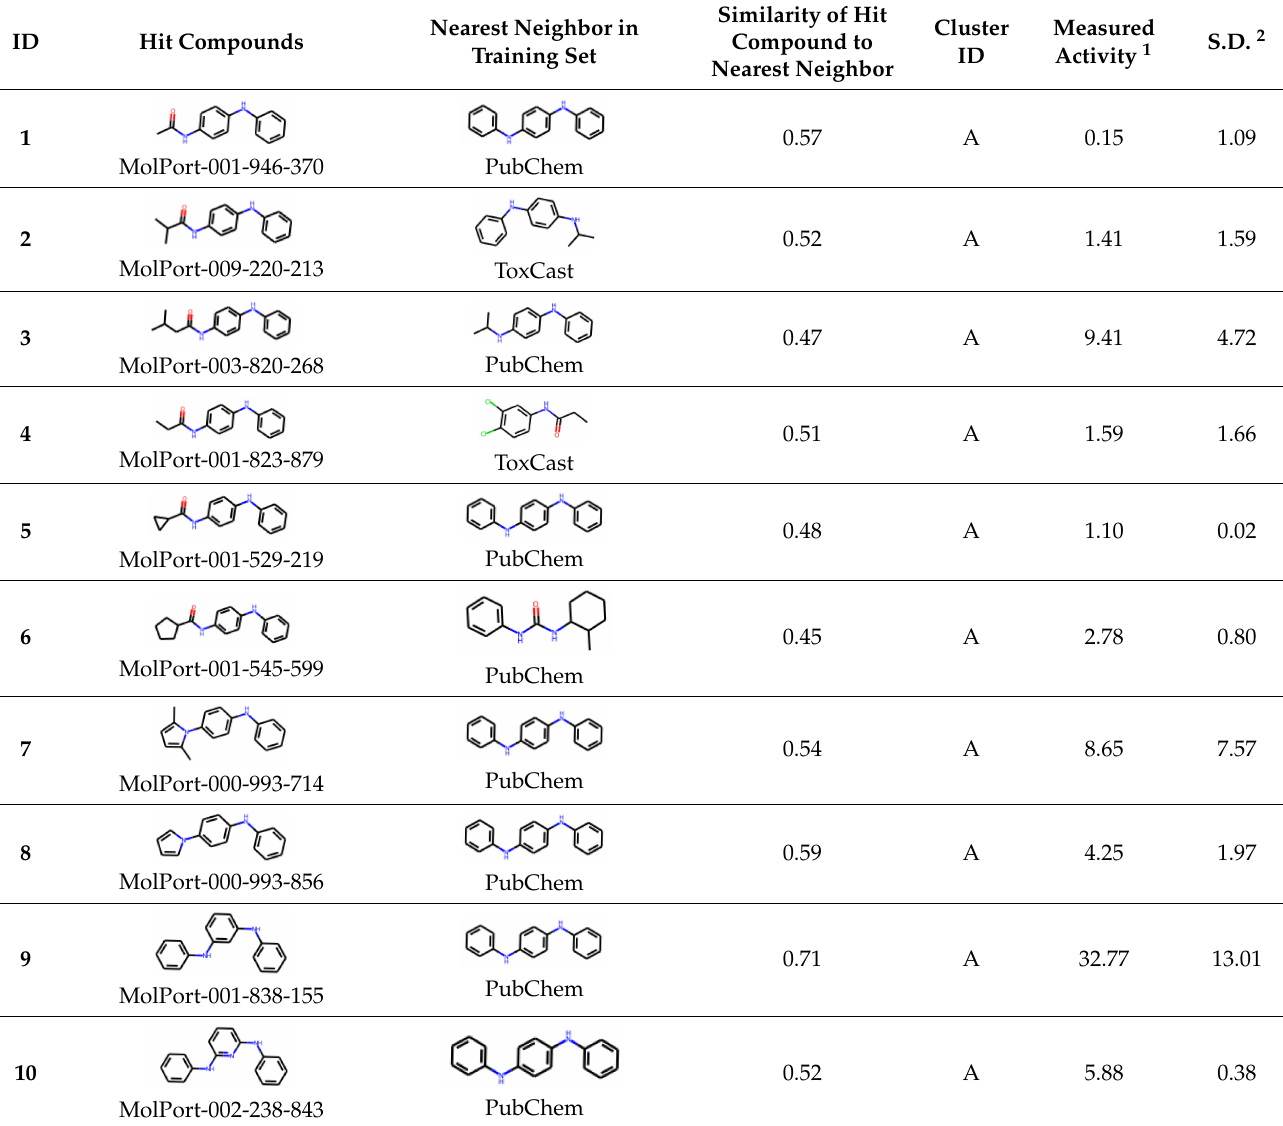
Table 4. Overview of Compounds Selected by Virtual